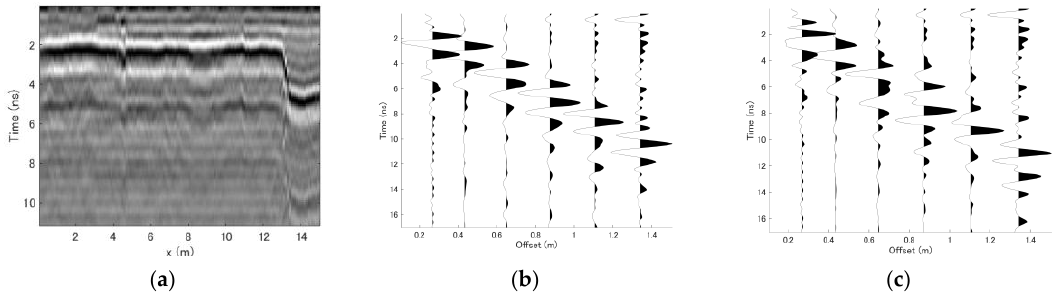
Figure 8. Datasets obtained along the survey line. ( a ) Vertical slice of the survey line obtained using 0.24 m antenna offset. ( b ) CMP dataset at x = 0.5 m. ( c ) CMP dataset at x = 8.5 m, where the manmade fracture zone was detected.